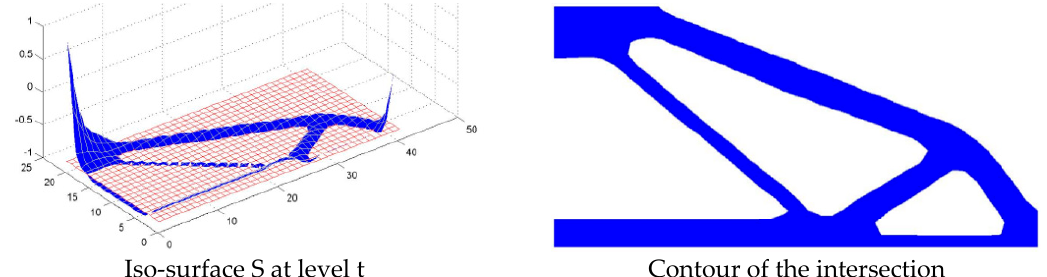
Figure 7. Illustration of a response surface, an iso-surface S and contour of the intersection.